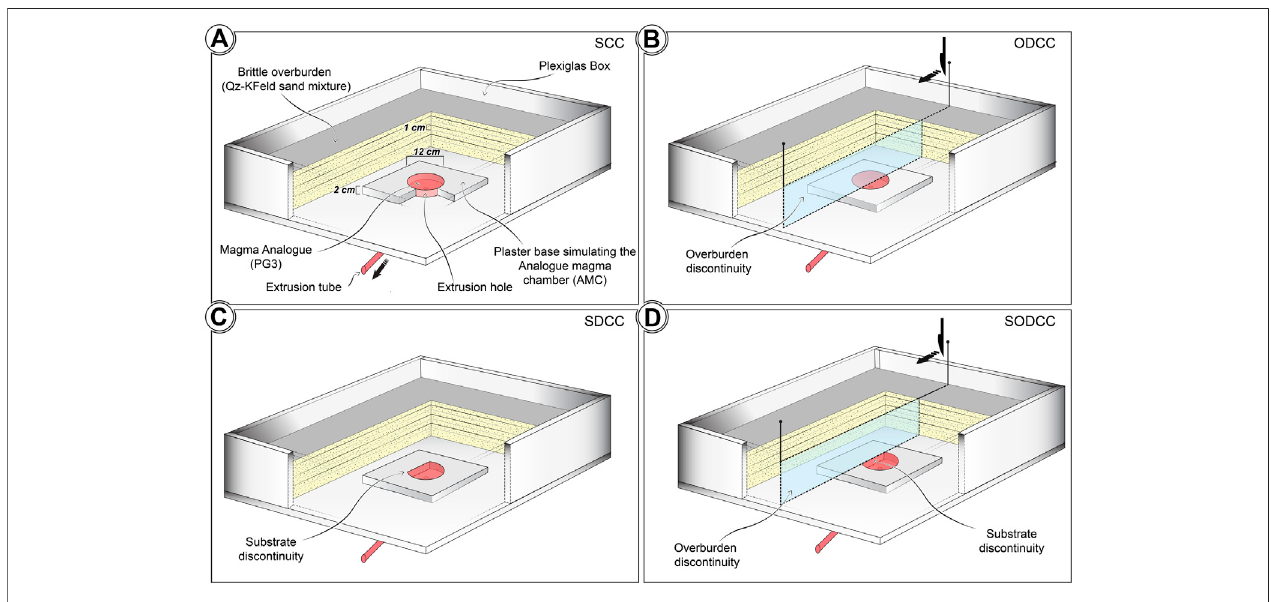
FIGURE 1 | Sketch of the analogue model setup. (A) Basic caldera collapse (SCC setup), with a circular analogue magma chamber (AMC) and no inherited discontinuities. (B) Basic setup with an overburden discontinuity (ODCC setup). (C) Setup investigating the effect of a substrate discontinuity (SDCC setup). (D) CombinationofODCCandSDCCsetups,investigatingtheeffectofasubstratetooverburdendiscontinuity(SODCCsetup).Notethatin “ b-d ” thesetupsshowonesub- vertical discontinuity in the substrate and/or overburden, but models were also designed with two sub-vertical orthogonal discontinuities, or 60 ° inward/outward dipping discontinuities. The speci fi c setup is shown for each model in the database.